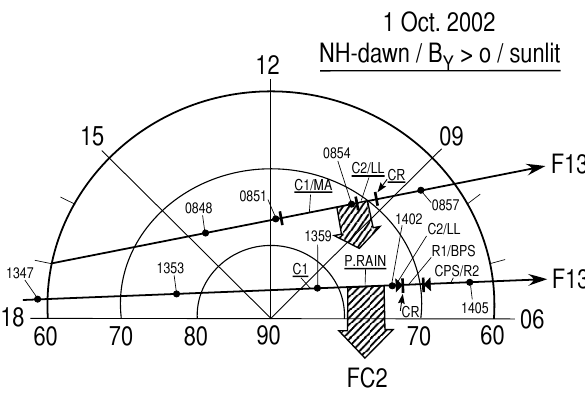
Fig. 5. DMSP F13 tracks across the polar cap in the Northern Hemi- sphere (NH) shown in MLT/MLAT coordinates during the inter- vals 08:48–08:57 and 13:47–14:05UT. The event category is NH- dawn/ B y > 0 (sunlit). Convection channel FC 2 is marked by the broad hatched arrow. Particle precipitation (CPS, MA, P.RAIN) and Birkeland current regimes (R2 (CPS), R1 (BPS), C2 (MA/P.RAIN), C1 (MA/P.RAIN)) are marked along the track, on the dawn (right)